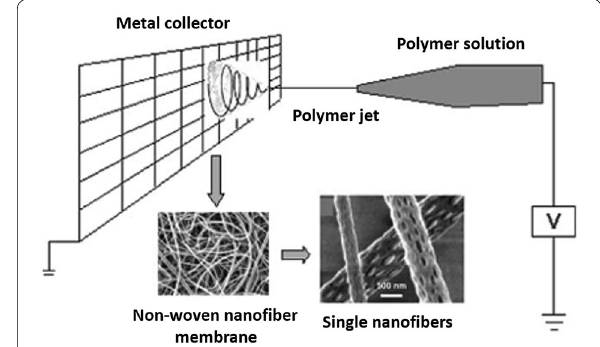
Fig. 8 Scheme of basic electrospinning. (Reprinted from